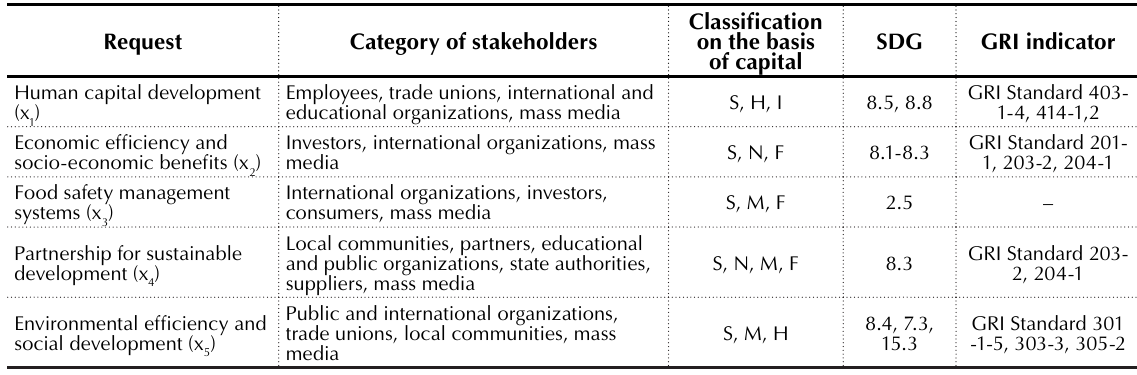
Table 4. Information requests of MHP stakeholders, adjusted for the sustainability context Source: Developed by authors on the basis of own approach and Global Reporting Initiative